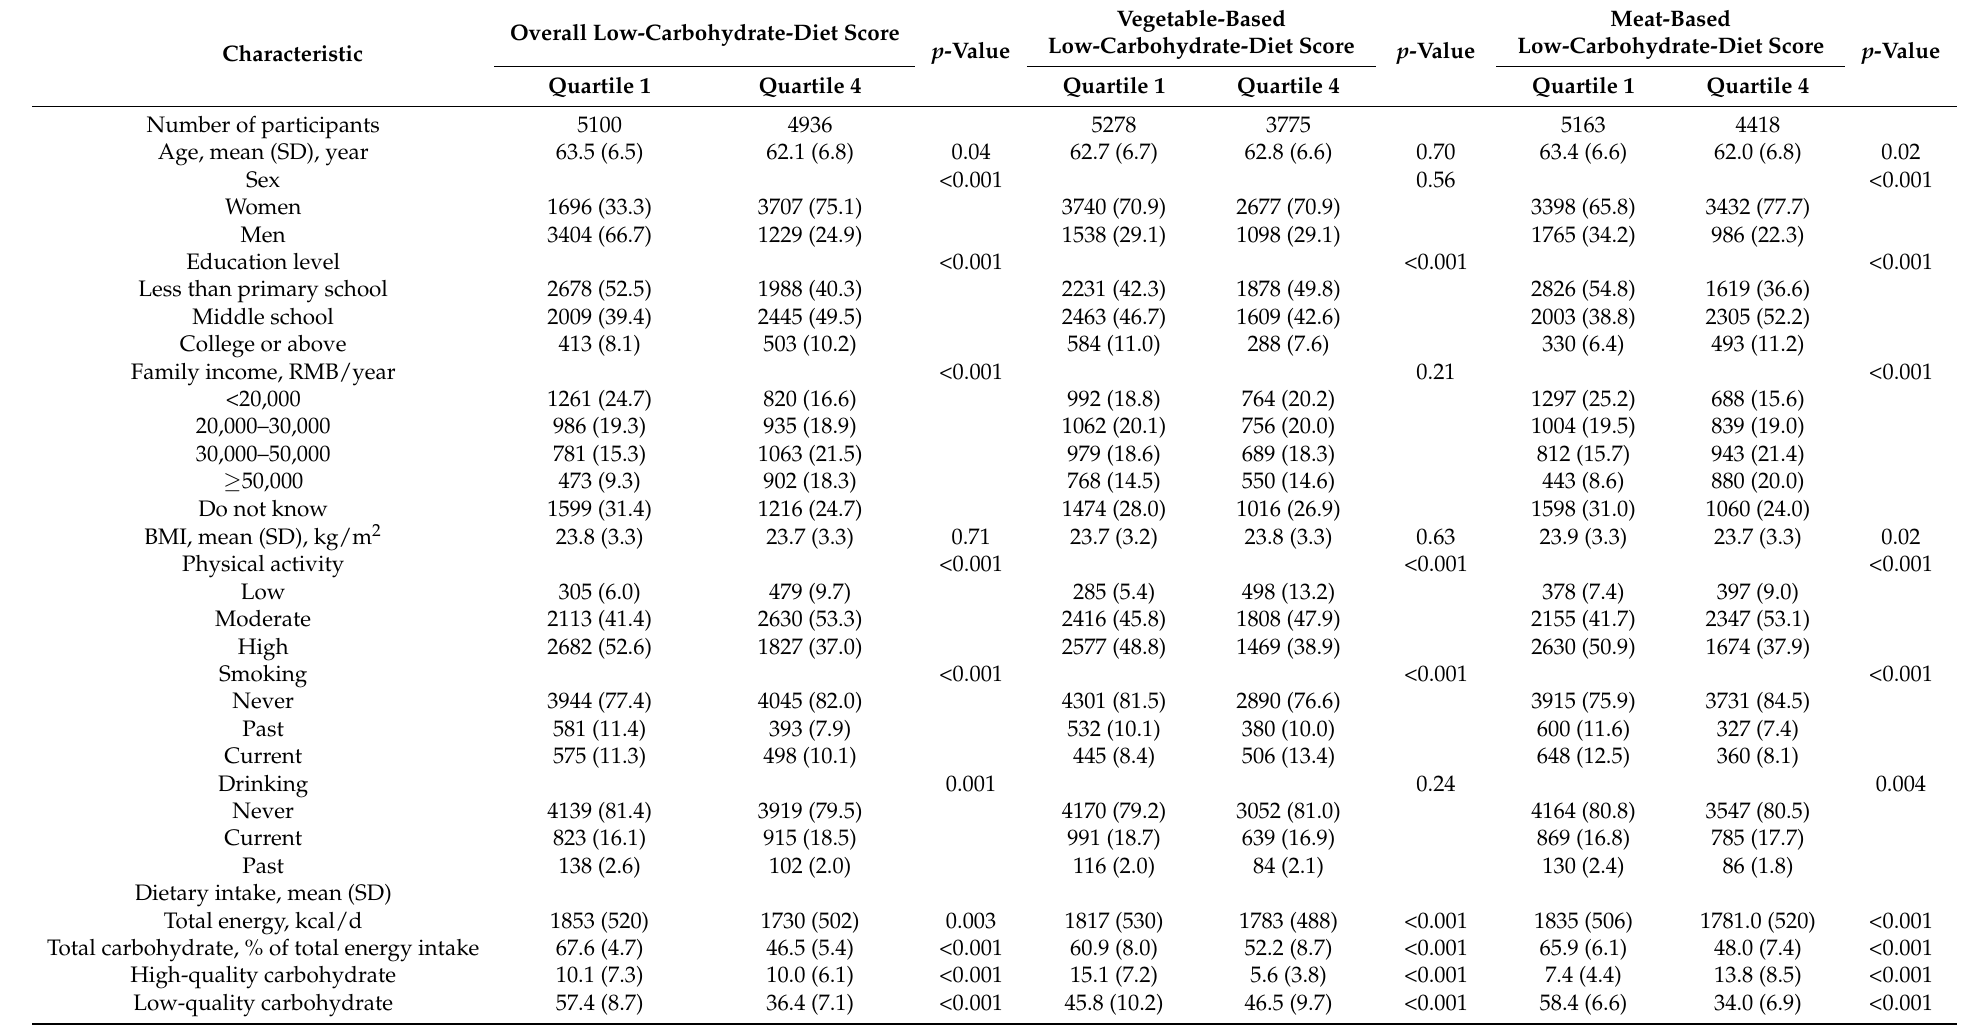
Table 1. The baseline characteristics by quartiles of low-carbohydrate-diet scores in 20,206 participants recruited from 2003–2008 a . Overall Low-Carbohydrate-Diet Characteristic